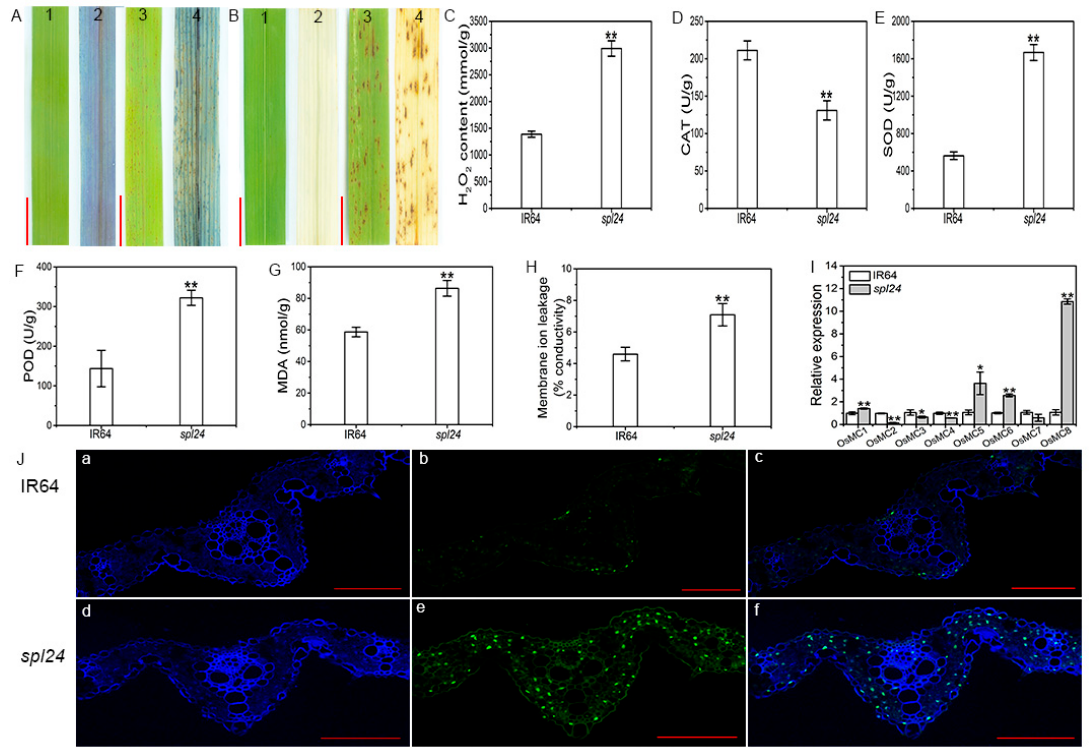
Figure 4. Analysis of cell death and ROS-associated parameters in IR64 and spl24 . ( A ) Typan blue staining. 1, IR64; 2, IR64 after staining; 3, spl24 ; 4, spl24 after staining; bar = 1 cm; ( B ) DAB staining. 1, IR64; 2, IR64 after staining; 3, spl24 ; 4, spl24 after staining; bar = 1 cm; (C) H 2 O 2 content at the heading stage; ( D – F ) the enzymatic activities of CAT, SOD, POD in the flag leaves. CAT, catalase; SOD, superoxide dismutase; POD, peroxidase; ( G ) malonaldehyde (MDA) contents of the flag leaves; ( H ) membrane ion leakage rates at the heading stage; ( I ) expression analysis of OsMCs at the heading stage; ( J ) TUNEL assay at the heading stage. Blue signal represents 4 ′ ,6-diamino-phenylindole (DAPI) staining; green color represents positive result. (a) and (d) are DAPI staining; (b) and (e) are TUNEL signal; (c) and f are merged images of (a/b) and (c/d) respectively, bar = 100 µ m. Values are means ± SD ( n = 3); ** indicates significance at p ≤ 0.01 and * indicates significance at p ≤ 0.05 by Student’s t test.